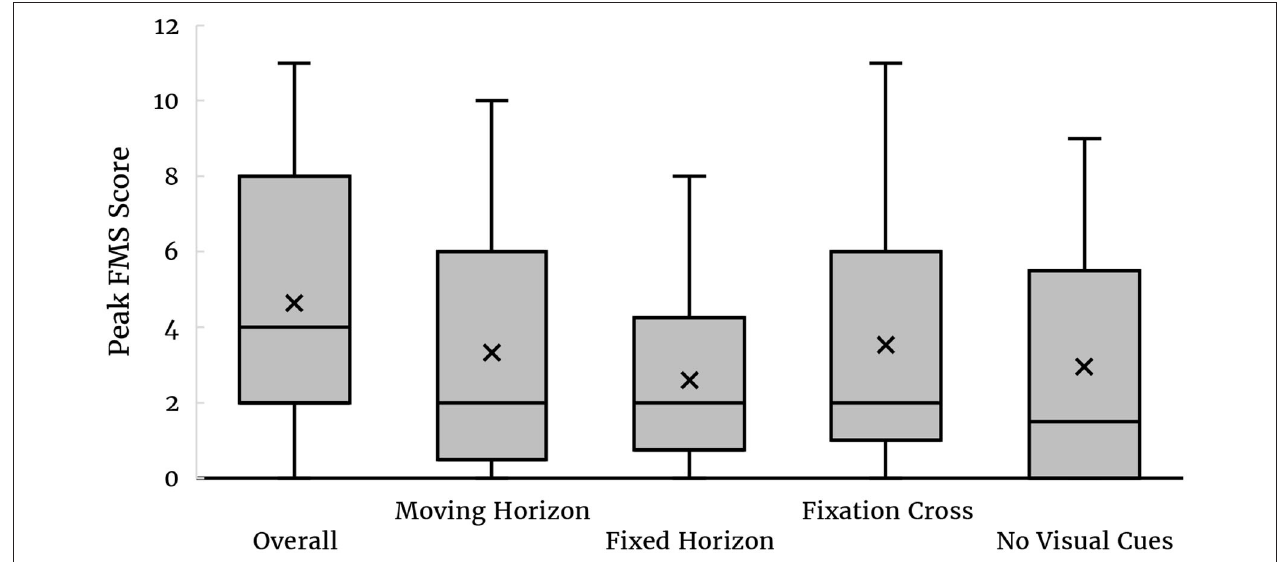
FIGURE 3 | Box-plots of overall peak FMS across all conditions and peak FMS scores for each condition. The line in the middle of the box indicates the median value. The cross represents the mean.